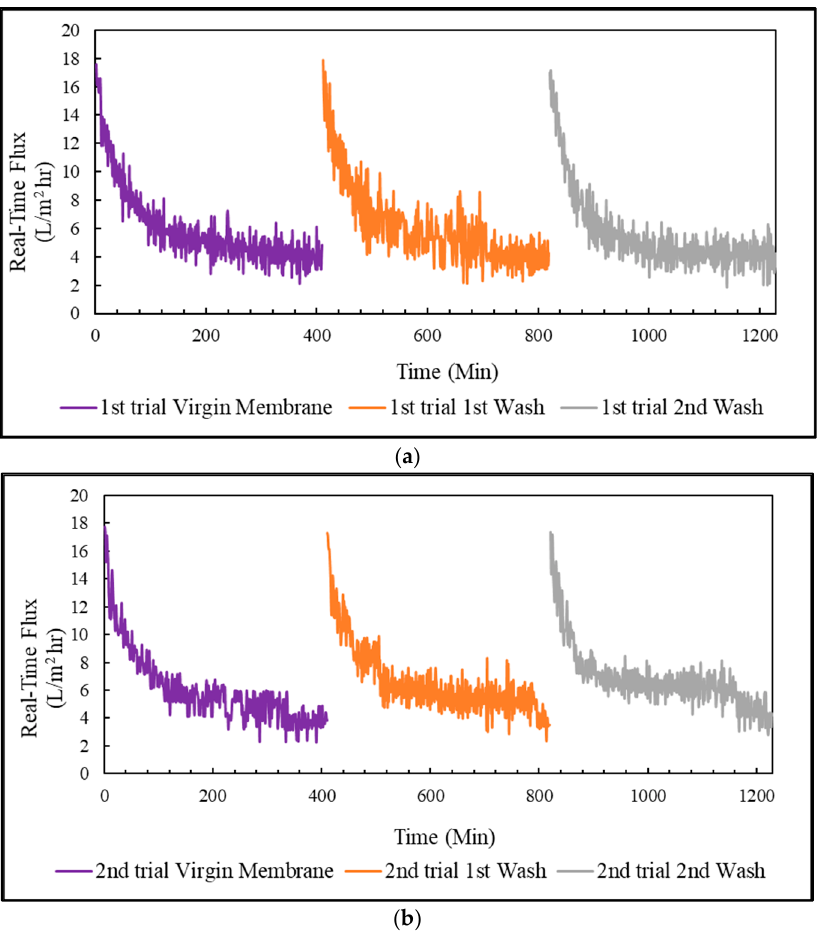
Figure 9. PSWW treatment with the coated membrane in PRO mode: ( a ) 1st trial of the coated membrane in PRO mode; ( b ) 2nd trial of the coated membrane in PRO mode.